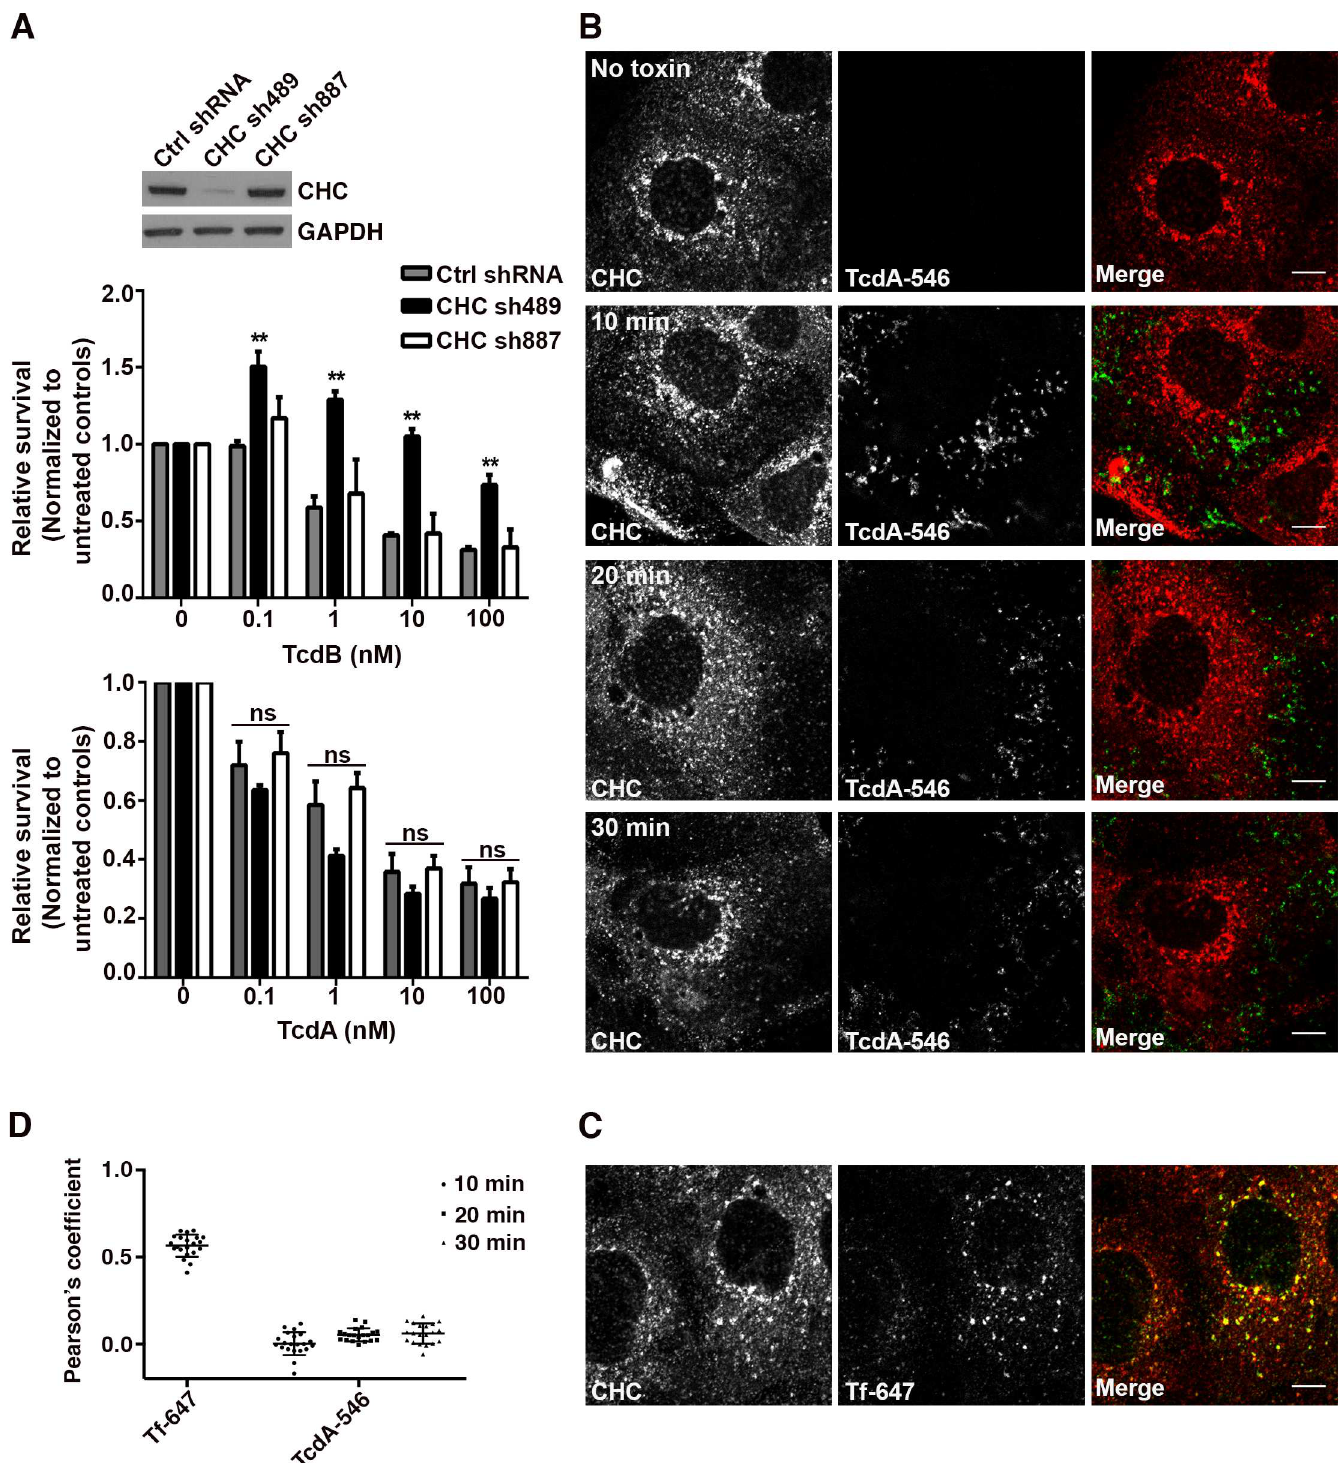
Fig 1. TcdA and TcdB utilize distinct endocytic mechanisms to intoxicate colonic epithelial cells. (A) Depletion of clathrin heavy chain (CHC) does not affect TcdA-induced cytotoxicity. Caco-2 cells expressingnon-targeting shRNA (Ctrl shRNA) and shRNAs 489 and 887 targeting two different sequencesin CHC were treated with indicatedconcentrations of TcdB or TcdA in triplicate. ATP levels were determinedusing CellTiterGloand normalized to signal from untreatedcells to assess the relativesurvival of cells post-toxin treatment. Results represent the mean and SEM of three independent experiments. Data were analyzedusing two-way ANOVA and p-values were generated using Dunnett’s multiplecomparisons test in GraphPad Prism.